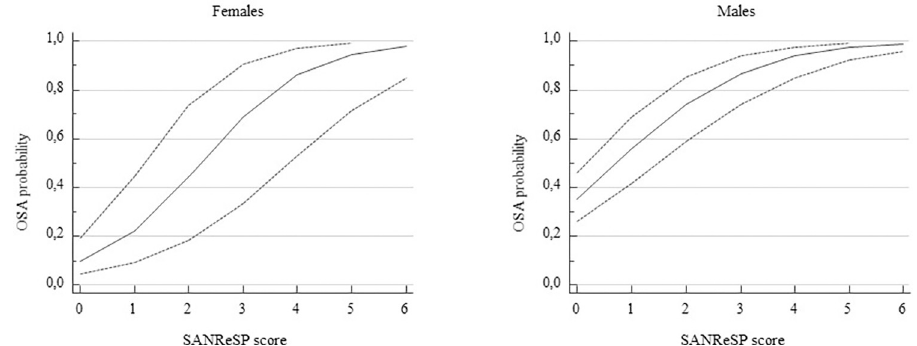
Fig 5. Predicted probabilities plot for AHI � 5/h, with the corresponding SANReSP score. Dashed lines indicate the 95% confidence intervals.